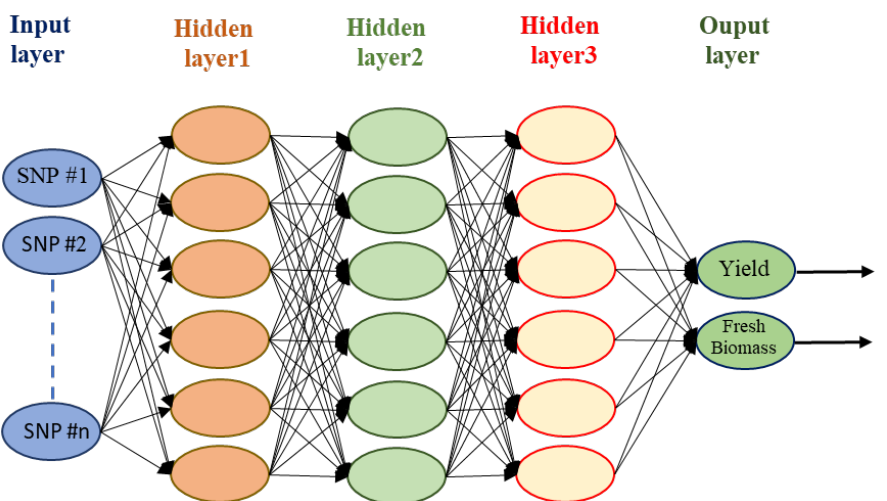
Figure 4. Schematic illustration of an artificial neural network used for predicting two outputs (yield and fresh biomass as an example) using molecular genetic markers, i.e., SNPs, dataset. This figure was created using Excel, Microsoft O ffice 2021.